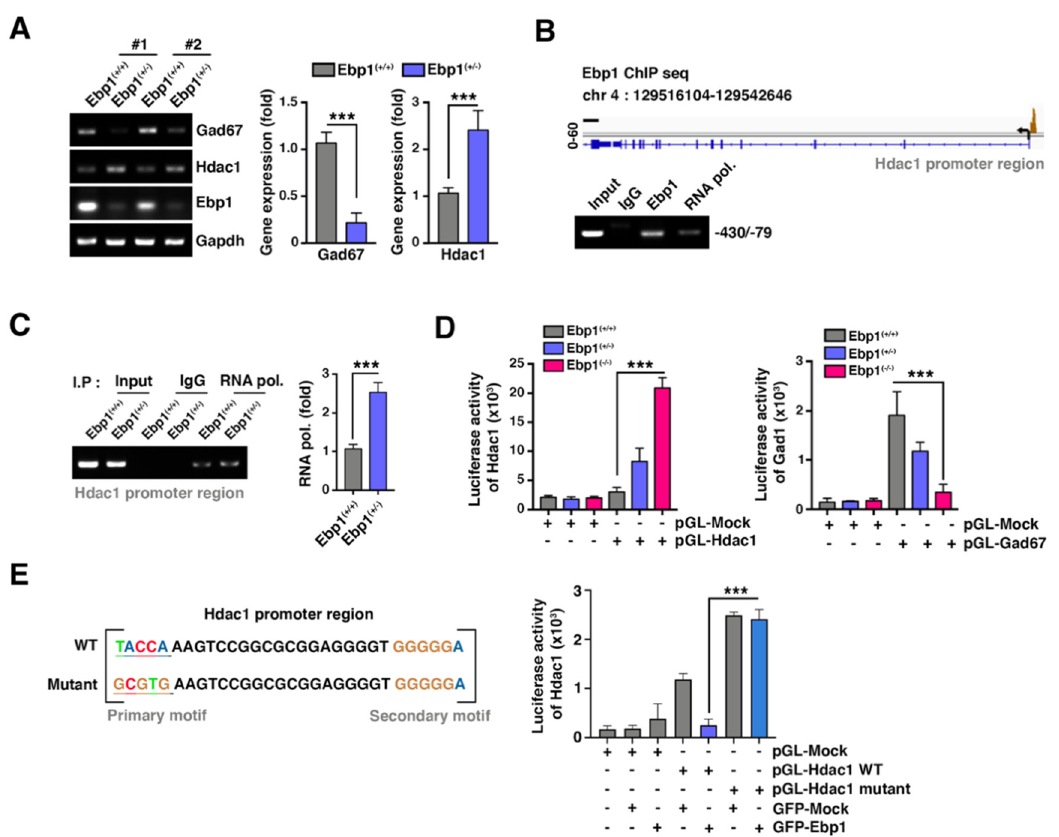
Figure 5. EBP1 repress histone deacetylase 1 (HDAC1) transcription and enhances Gad67 expression. ( A ) RNA expression levels of GAD67 and HDAC1 were measured using RT-PCR with samples of mouse hippocampus from Ebp1 ( +/+ ) or Ebp1 ( +/ − ) mice (left); RT-PCR quantification data is shown as bar graphs (right). *** p < 0.0001. ( B ) Chromatin immunoprecipitation analyses coupled with sequencing (ChIP-seq) analysis was performed with MEF cells and using anti-EBP1 antibody. Overview peak of the EBP1 binding site in the promoter region of HDAC1 gene (upper) is shown. ChIP assay was performed to confirmed EBP1 binding site on HdDAC1 promoter region was analyzed using RT-PCR (bottom). *** p < 0.0001. ( C ) MEF cells were subjected to ChIP assay with anti-IgG or RNA polymerase II antibodies to measure the binding of RNA pol II to GAD67 promoter region (upper). Quantification of the binding of RNA pol II to GAD67 promoter region is shown (bottom). *** p < 0.0001. ( D ) Luciferase activities of Dnmt1 (left), HDAC1 (middle), and GAD67 (right) were measured using the luciferase assay (Promega). Promoter regions of those genes were cloned using the pGL-4.12 vector and transfected into EBP1 MEF cells shown as Ebp1 ( +/+ ) , Ebp1 ( +/ − ) or Ebp1 (- / -) . *** p < 0.0001. ( E ) Identification of EBP1 binding motif and mutation in the predicted EBP1 binding site in the Hdac1 promoter are shown. Cells were co-transfected using pGL-Hdac1 promoter constructs (WT or mutant) along with the control or Ebp1 plasmids. *** p < 0.0001. All data are shown as the mean ±